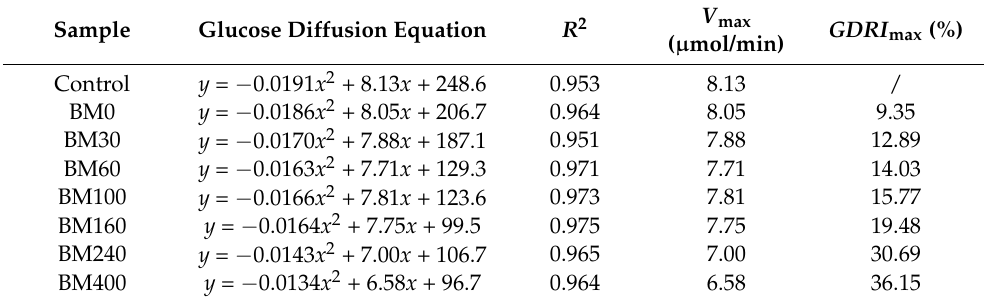
Figure 11. Effects of different PIDF samples on glucose diffusion ( a ) and GDRI ( b ). Table 2. Glucose diffusion characteristics in the glucose-PIDF